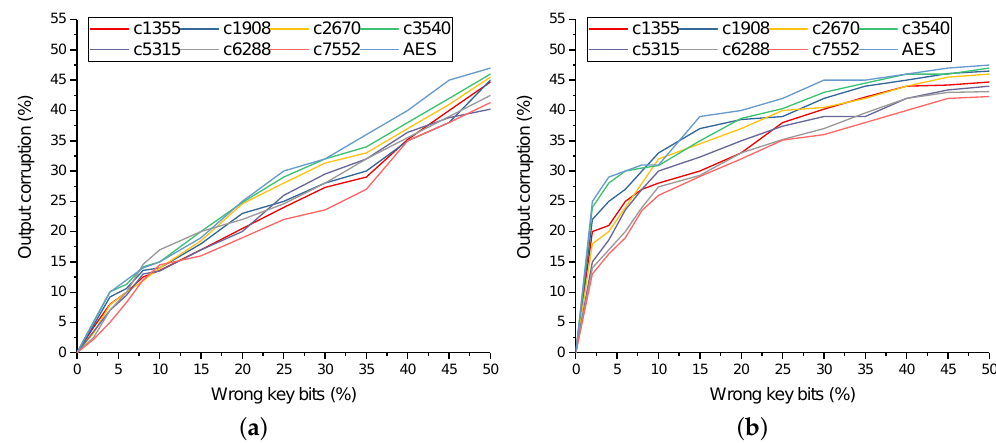
Figure 7. Comparison of the Hamming distance between the logic encryption without and with the key interdependency block for the wrong key bits. ( a ) Hamming distance for % wrong key bits without the key interdependency block. ( b ) Hamming distance for the wrong key bits with the key interdependency